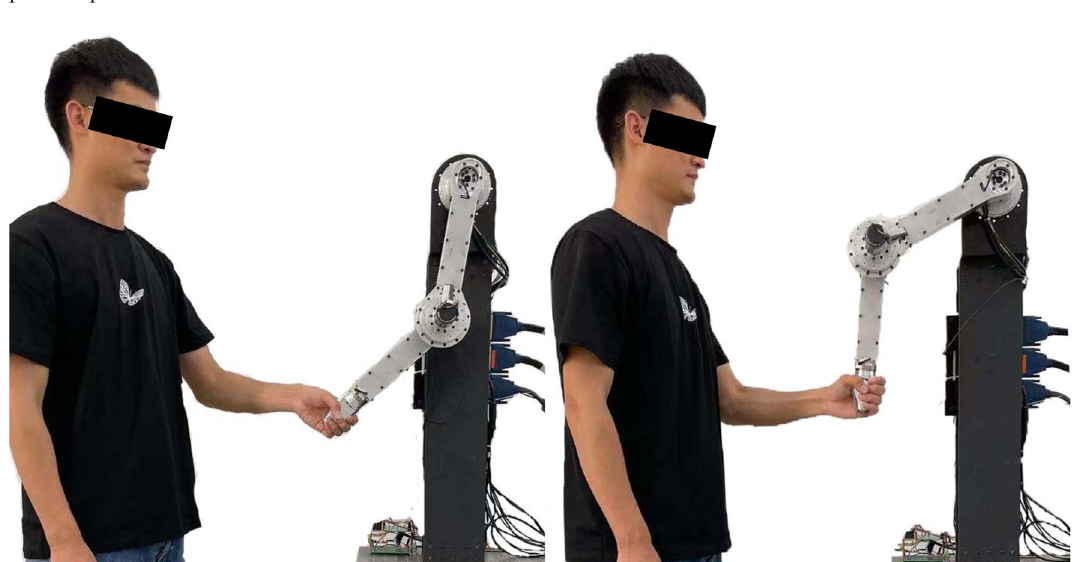
Fig. 4 pHRI experiment based on human motion intention estimation via harmonic drive compliance